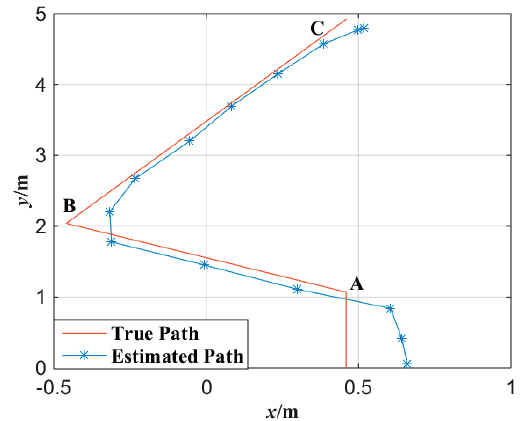
Figure 9. Trajectory tracked with the miner’s lamp video collaborative